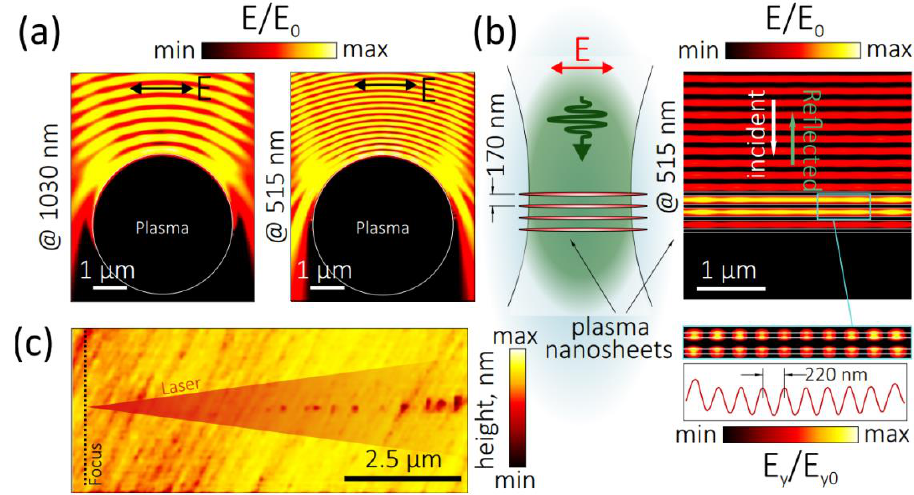
Figure 6. ( a , b ) Normalized electrical field amplitude (E/E 0 ) calculated in front of the focal plasma ( ε * 515 = − 2.25 + 0.3i) in fused silica upon its irradiation by a x-polarized plane wave at 1030-nm (left panel) and 515-nm (right panel) wavelengths. The incident and reflected waves produce radially longitudinal standing wave distribution with a characteristic period of λ /2 n in front of the plasma. ( b ) Schematically illustrated periodically arranged pre-focal 2D-plasma nanosheets (left panel) as well as calculated (E/E 0 ) distribution in their vicinity upon their exposure at 515 nm (top right panel). Bottom panel shows normalized y-component of the electrical field amplitude (E y /E 0 ) in the vicinity of nanosheets surface with a characteristic modulation period of 220 nm. ( c ) AFM cross-sectional height image of the pre-focal longitudinal array of relief nanobits produced by the tightly focused 1030-nm 0.3-ps laser radiation.